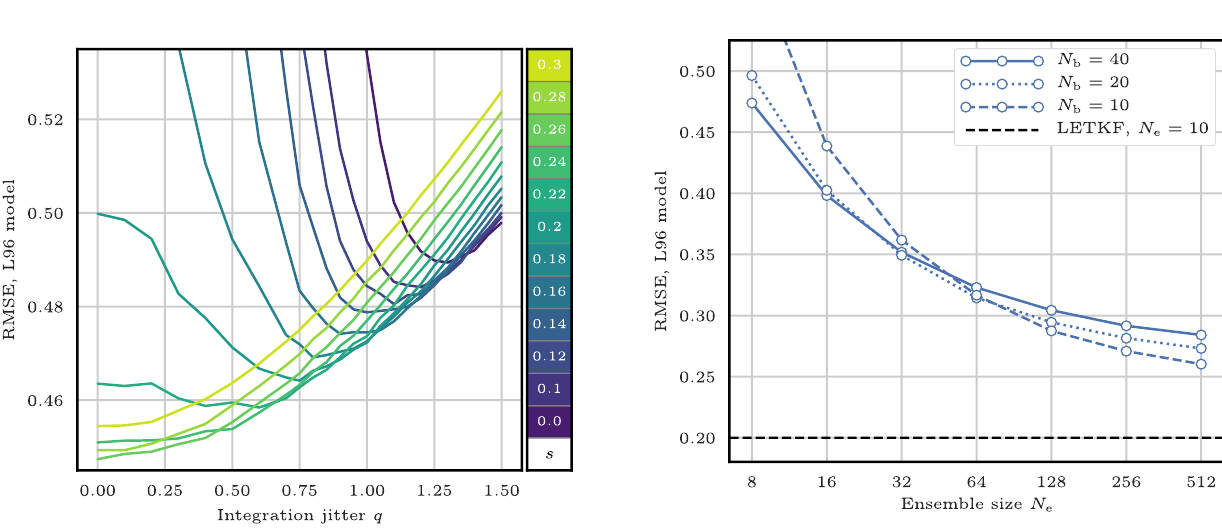
Figure 5. RMSE as a function of the localisation radius r for the S(IR) x R algorithm with N e = 10 particles, N b = 40 blocks of size 1 grid point, and no integration jitter ( q = 0). For each r , several val- ues for the regularisation jitter s are tested, as shown by the colour scale.